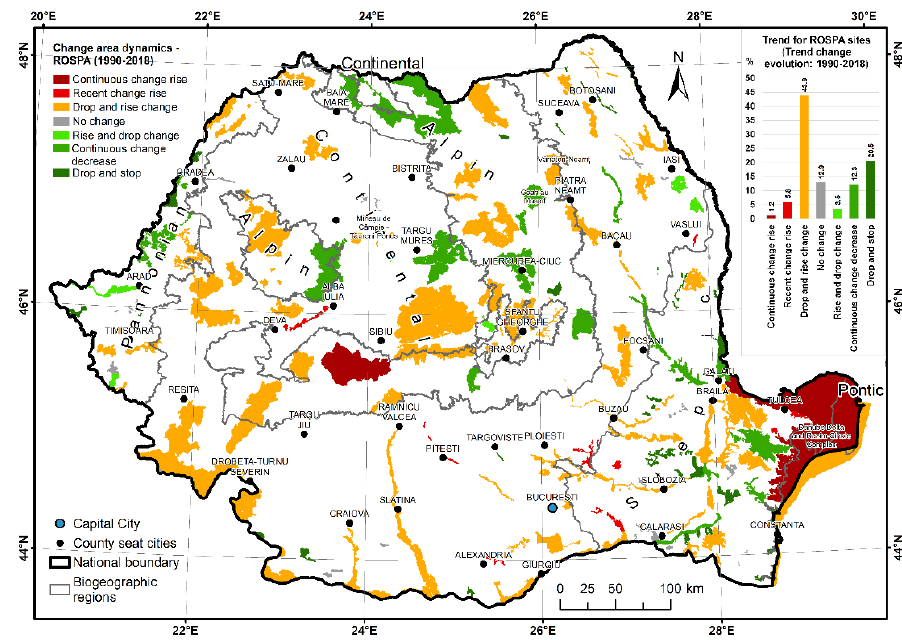
Figure 9. Distribution of the different patterns of dynamic behavior for ROSPA (1990–2018).